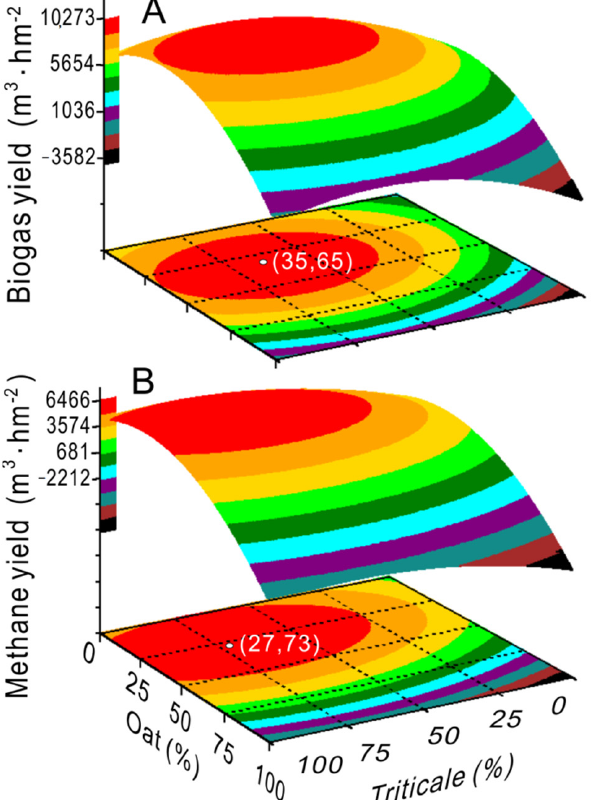
Figure 3. Response surface plots showing the interactions between oat and triticale on the biogas yield ( A ) and methane yield ( B ).